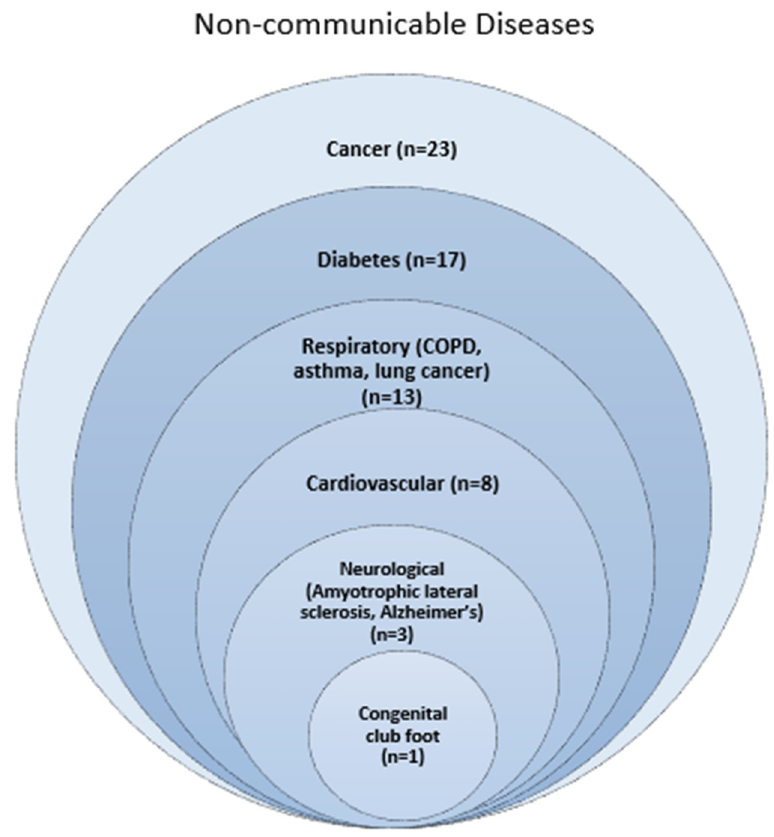
Figure 2. Number of studies focusing on each non-communicable disease.